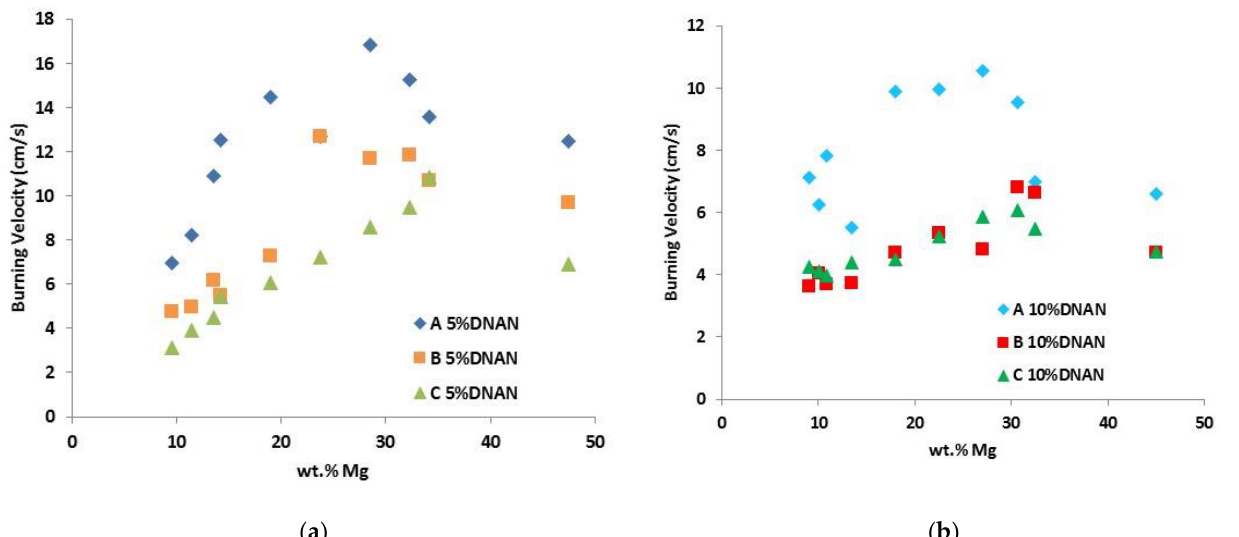
Figure 6. Influence of magnesium particle size on the burning velocity of ternary compositions containing 5 wt.% of DNAN ( a ) and 10 wt.% of DNAN ( b ).